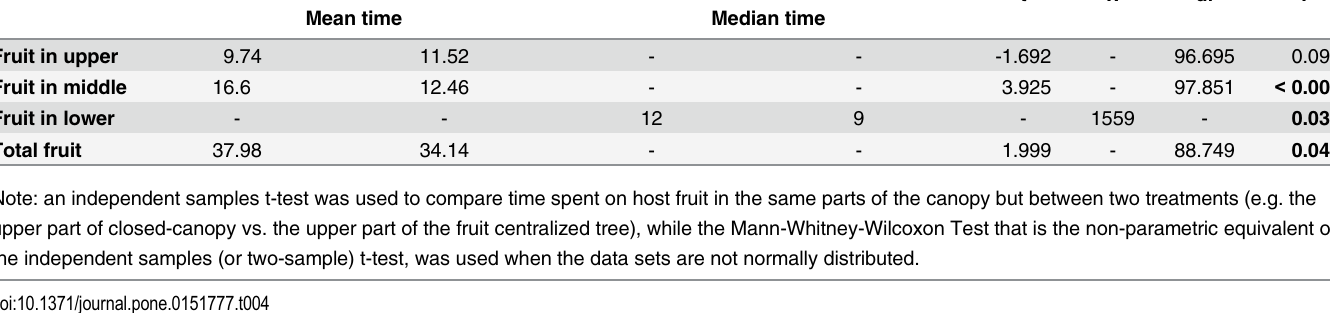
frugivorous fruit flies at different canopy heights is varied, and the increasing height is gener- ally associated with greater abundance of frugivorous fruit flies [24]. This argument can be sup- ported by data from the wild tobacco fruit fly, Bactrocera cacuminata (Hering) [30], the apple maggot fly, Rhagoletis pomonella (Walsh) [31], the Mexican fruit fly, Anastrepha ludens (Loew) [32], and the Mediterranean fruit fly, Ceratitis capitata (Wiedemann) [33]. In particu- lar, the model predictions match with the findings by Balagawi et al. [24] in terms of the pat- terns of abundance of B . tryoni in different heights of canopy, in which fewer B . tryoni are